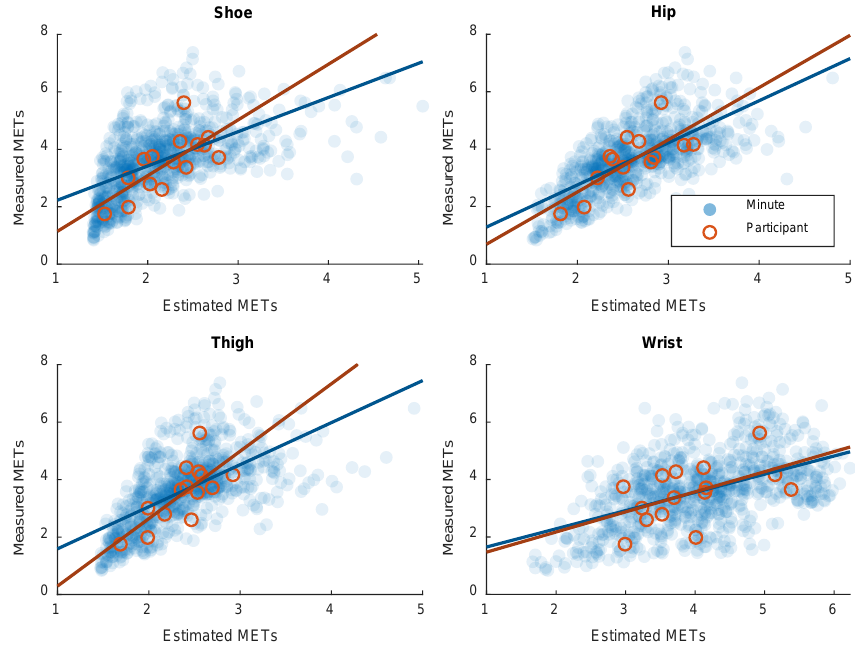
Figure 2. Correlation plots between estimated and measured energy expenditure (METs) based on minute-by-minute measurement and participant mean (free-living part).